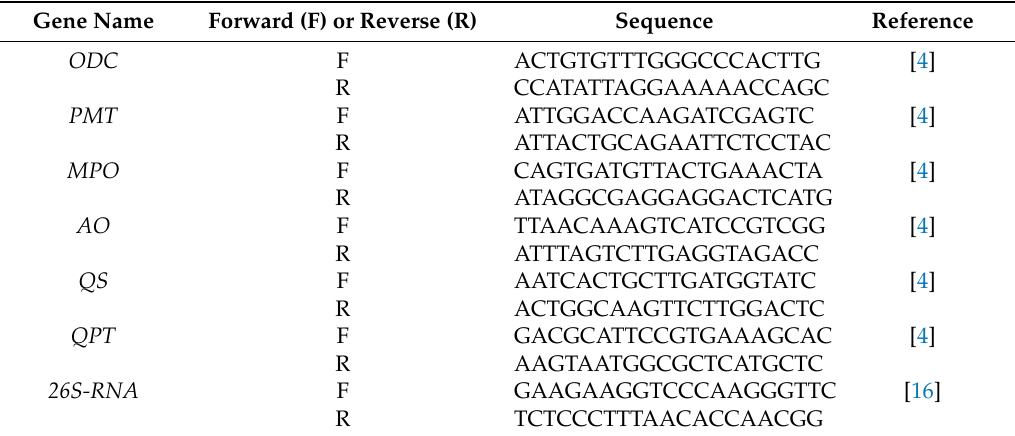
Table 2. Primer sequences for quantitative real-time polymerase chain reaction